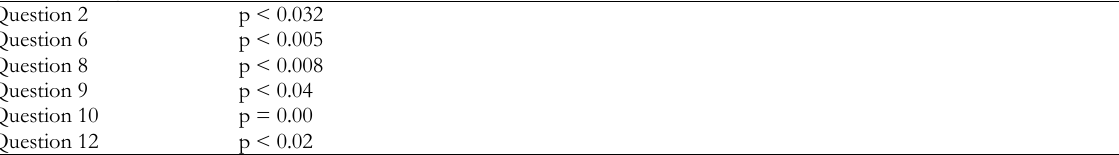
Table 3. Significance Found in Survey Questions